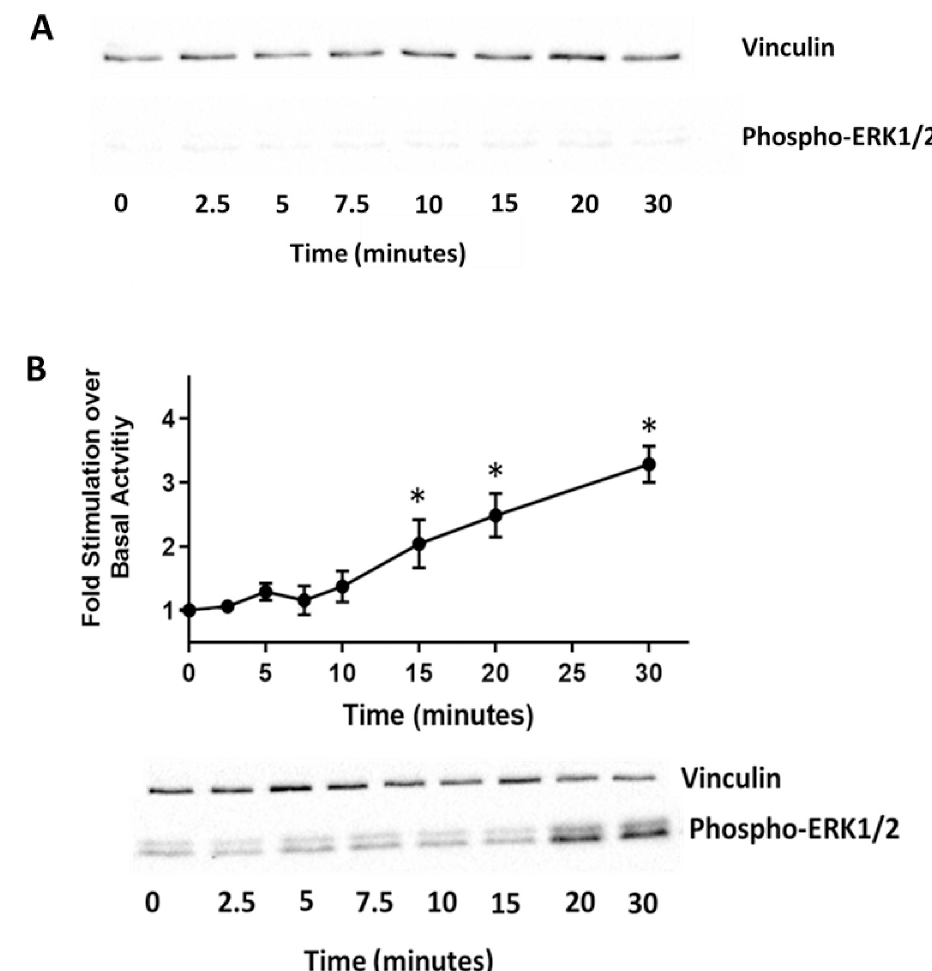
Fig 4. ERK1/2 Phosphorylation profiles. A) Unstimulated HUVEC displayed no activity after incubation with 1 μ M N/OFQ. B) Stimulation of ERK1/2 in LPS/PepG treated HUVEC by 1 μ M N/OFQ was measured over 30 minutes. Representative Western blots are shown below the graph. Data are the mean ± SEM from 20 separately cultured lines. Analysis was undertaken on raw data using ANOVA and Bonferroni post hoc analysis, � statistically greater than raw basal activity (p <